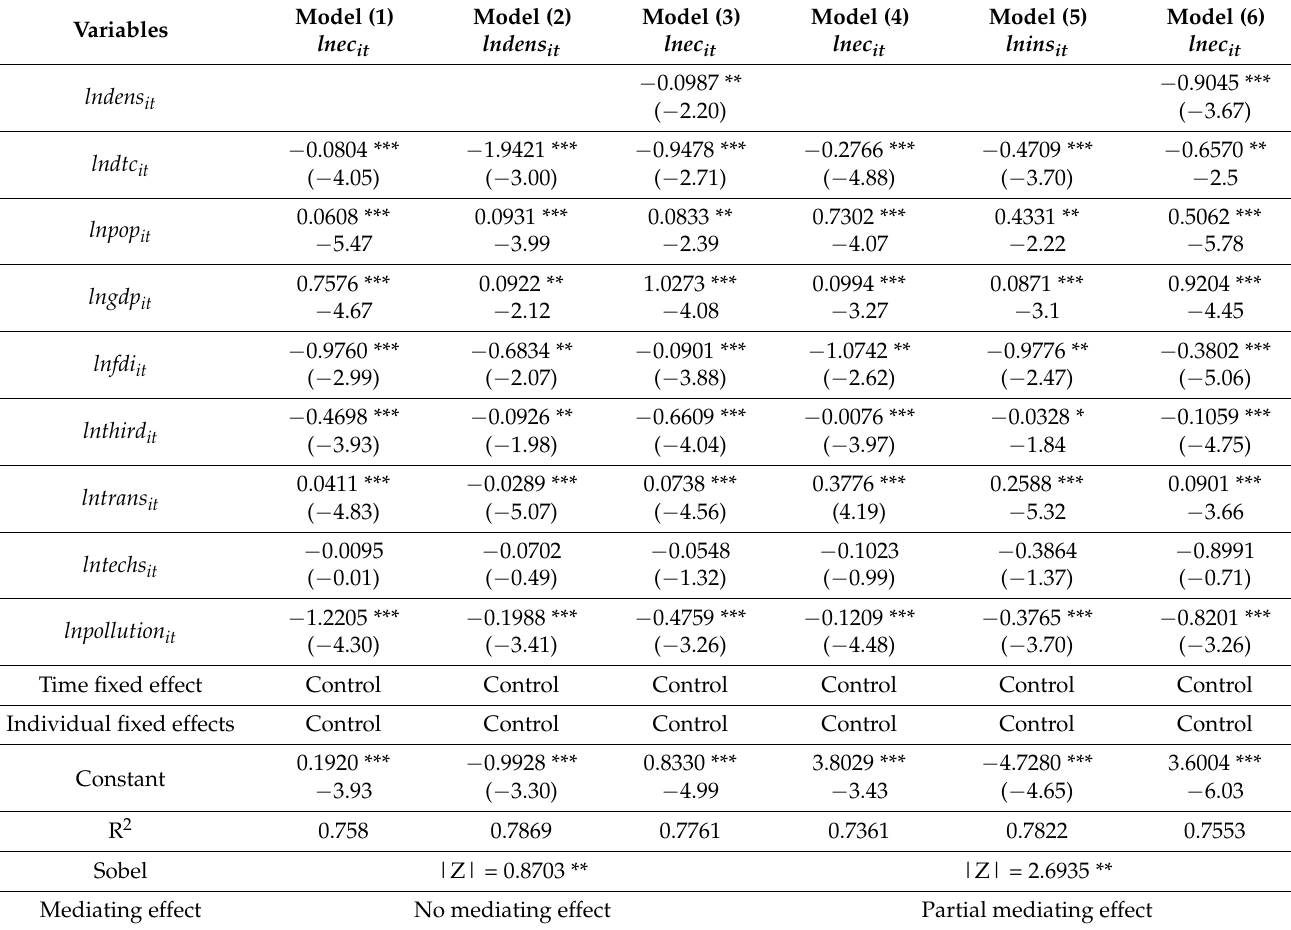
Table 5. Mediation effect regression results of population density and industrial